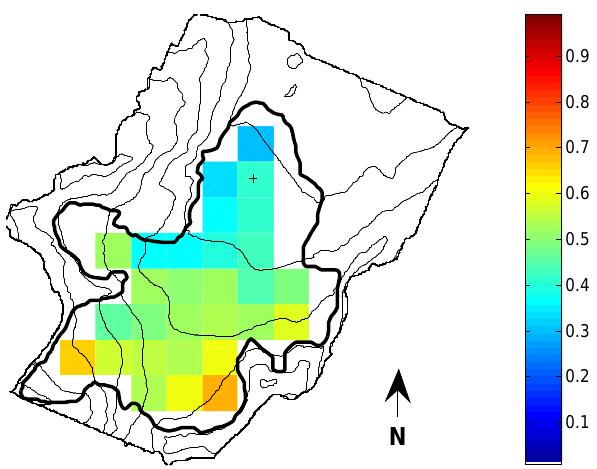
Fig. 4. Clear sky albedo retrieved from MODIS on 16 July 2007. This map has been retrieved using anisotropic/topographic correc- tions and DISORT. The pixel indicated by the plus is the pixel used for the monitoring of the albedo in the ablation zone. All the coloured pixels are used to compute the mean albedo of the